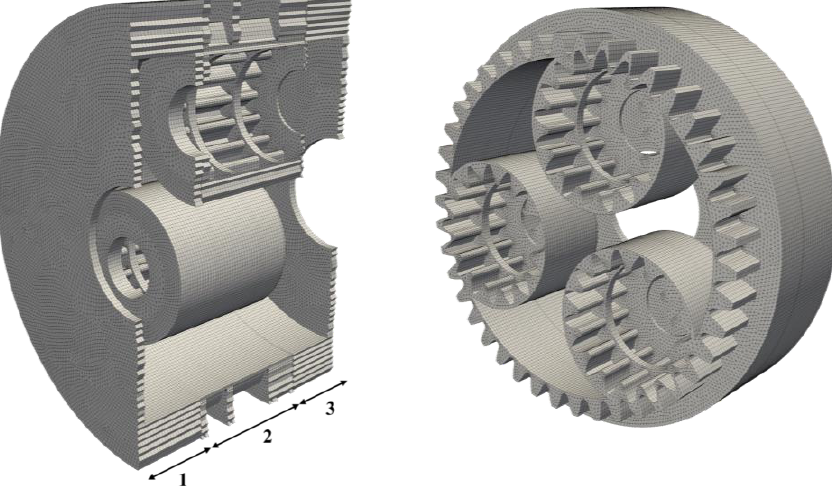
Figure 3. Longitudinal and cross views of the assembled mesh. A full extruded mesh is obtained.